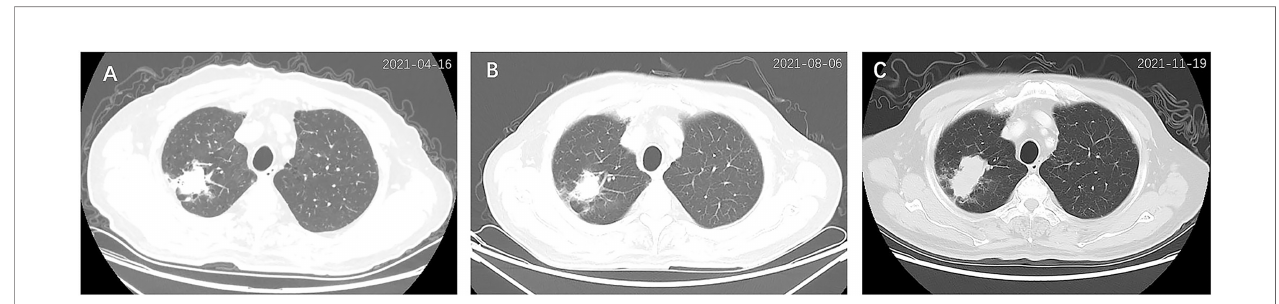
FIGURE 1 | Chest computed tomography (CT) scan of the primary lung cancer at diagnosis (A) , 3 months after treatment (B) , and 6 months after treatment (C) . An irregular mass (3.5 cm × 2.7 cm) was detected in the right upper lobe (A) , which shrunk (2.6 cm × 2.2 cm) after 3 months of treatment (B) but enlarged (5.2 cm × 2.6 cm) after 6 months of treatment (C)